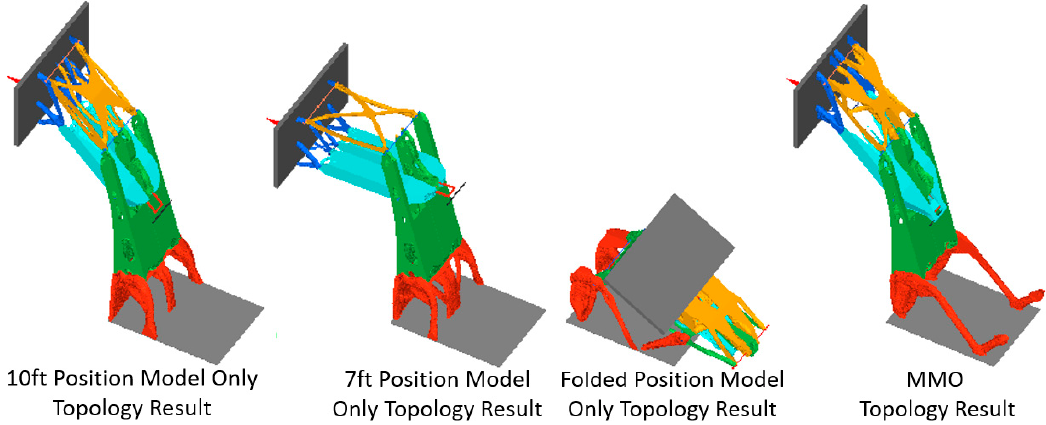
Figure 3. Comparing individual topology optimizations with multimodel optimization